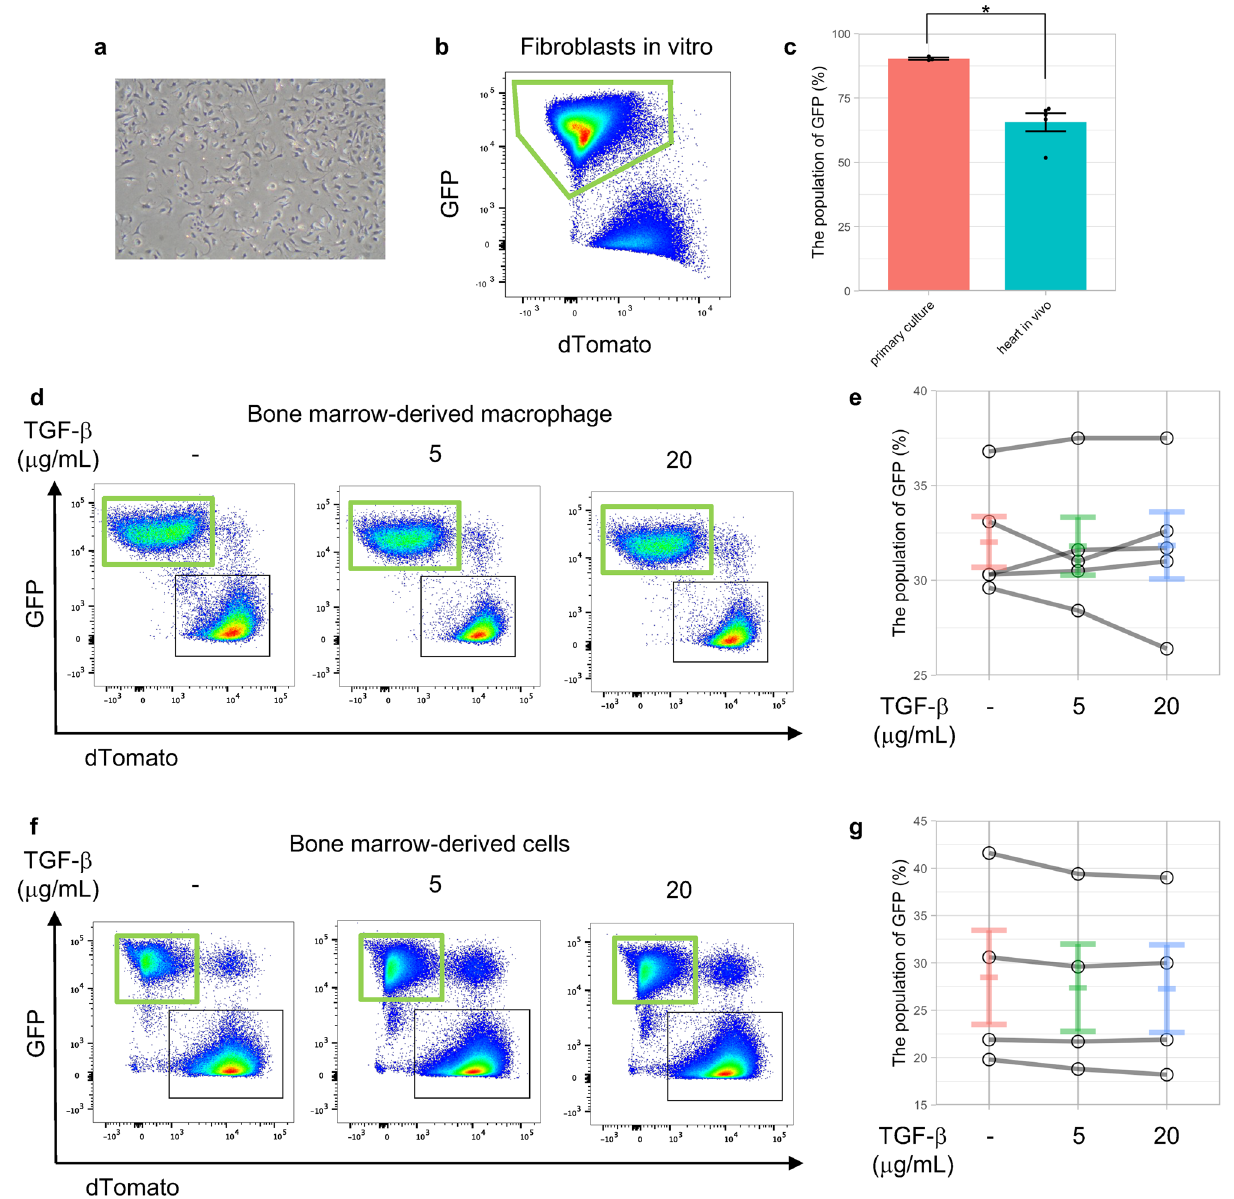
Figure 4. SM22α-Cre recombination in vitro. ( a ) A representative bright field image of cultured fibroblasts. ( b ) GFP expression in fibroblasts in vitro. ( c ) GFP expression in fibroblasts in vitro (n = 3) and in vivo (n = 5). *p value < 0.01, evaluated by Student’s t test. ( d ) GFP expression in BMDMs with TGF-β stimulation. ( e ) No additional SM22α-Cre recombination in BMDMs with TGF-β stimulation, which increases SM22α expression. ( f ) GFP expression in bone marrow-derived cells with TGF-β stimulation. ( g ) No additional SM22α-Cre recombination in bone marrow-derived cells during differentiation from phenotypically defined putative HSCs to macrophages with TGF-β